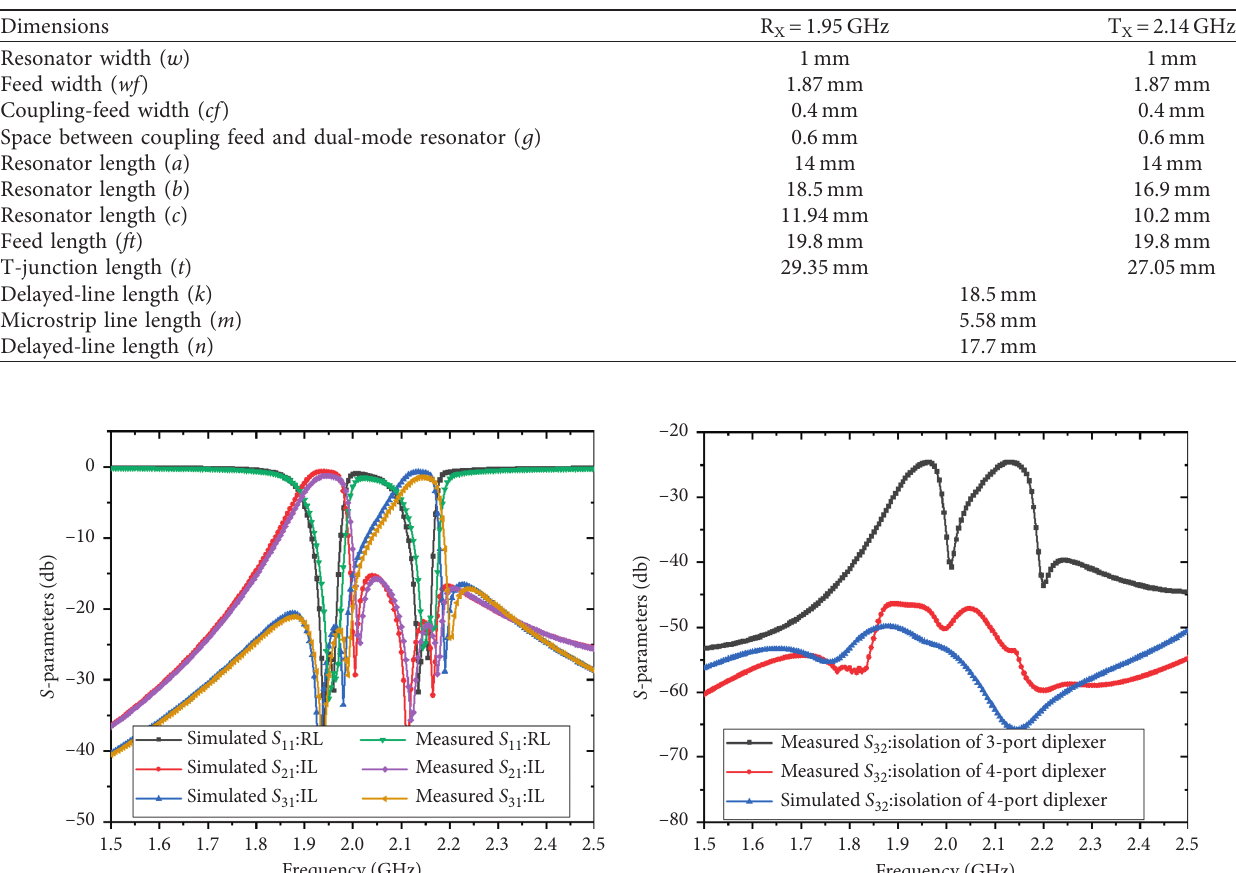
32 ) between three-